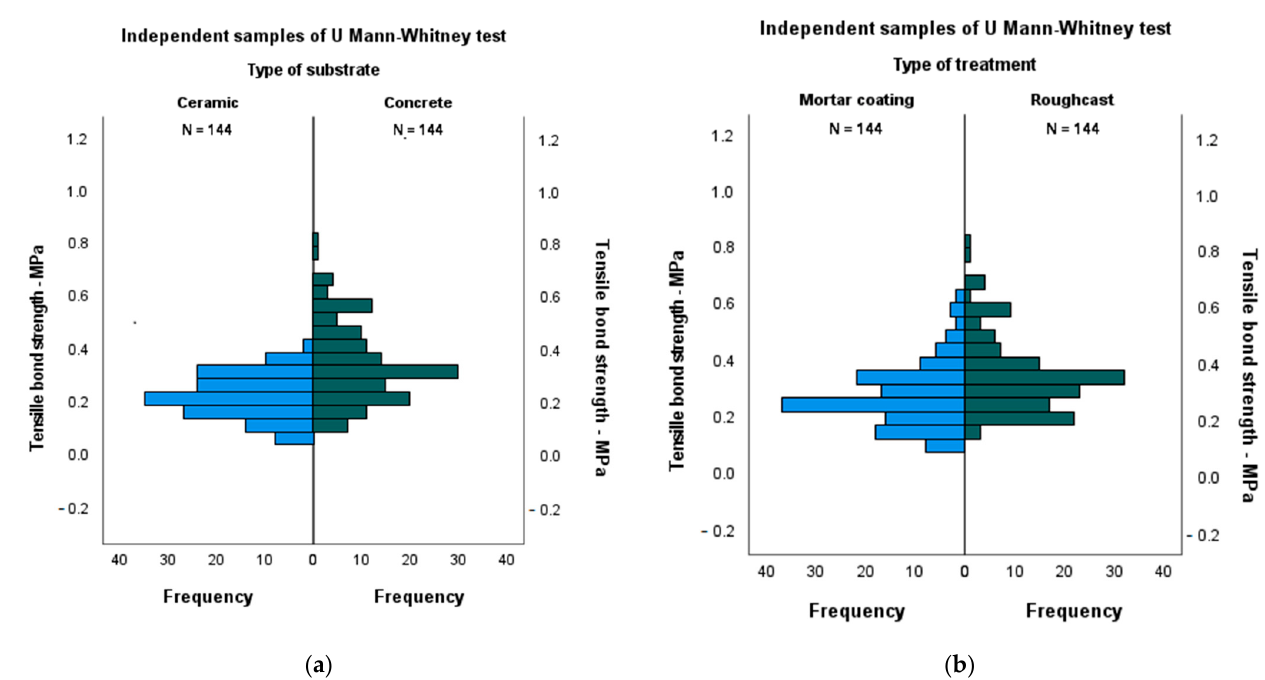
Figure 6. U Mann–Whitney test for ( a ) the type of substrate and ( b ) for the type of treatment. Table 8. Mann–Whitney test statistic result for the influence of the type of substrate and type of treatment on the tensile bond